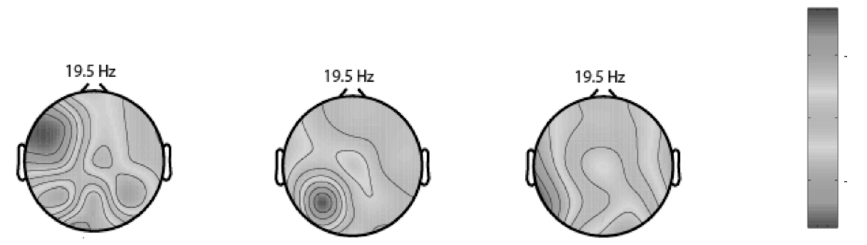
Figure 4. Experimental results regarding the brain activity, recorded during different times of the video. The colored bar shows the power of the signal (frequency of 19.5 Hz)—darker high power, lighter low power.